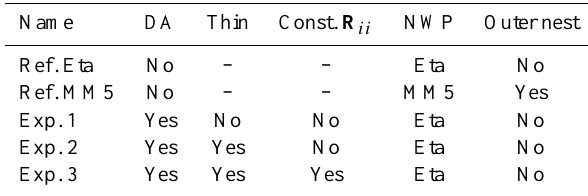
Table 1. A summary of the differences between the experiments. Abbreviations used: DA – whether data assimilation was applied, Thin – thin satellite data to a given resolution, Const. R – use constant observation errors for each month, NWP – the numerical weather prediction model used to provide the meteorological